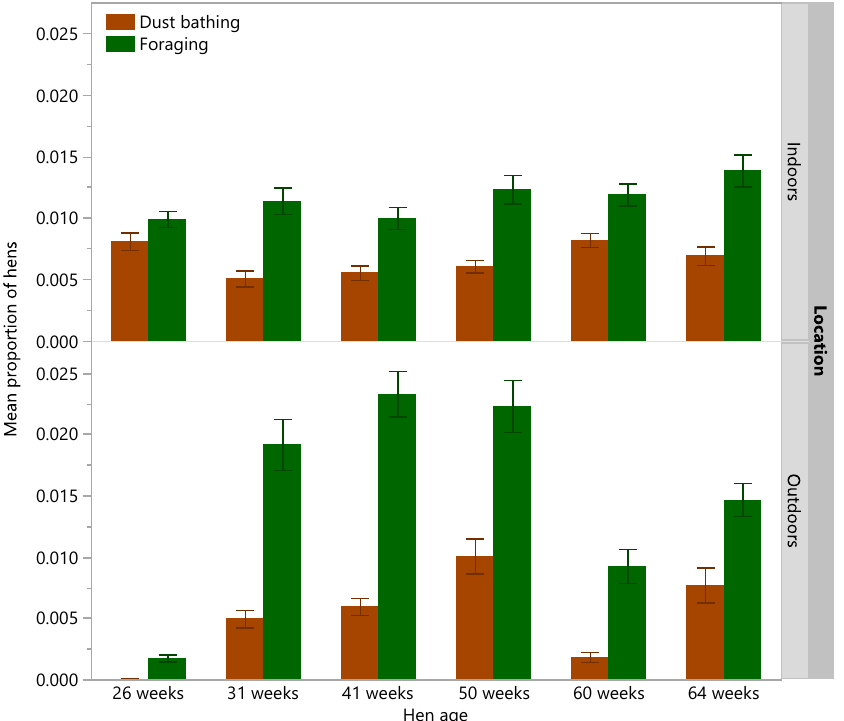
Figure 6. The mean (±SEM) proportion of hens inside the shed (indoors) or outside on the range (outdoors) exhibiting dust bathing or foraging behavior across hen ages (26, 31, 41, 50, 60, 64 weeks). Raw data are presented from all rearing treatments combined.